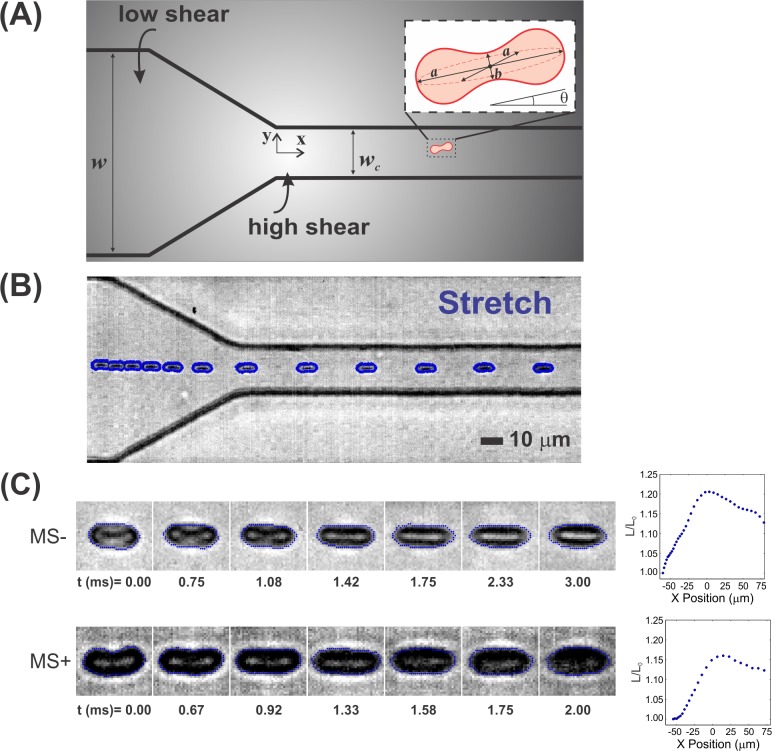
(A) Schematic of the microfluidic device. Dilute RBCs are pumped from a region of low shear (a wide channel, at left) to a region of high shear (the constriction, at right). Note that the origin is at the center of the entrance of the constriction as shown on the figure. (B) Representative superimposed series of time-lapse images extracted from high speed video each showing an individual RBC entering a constriction and stretching in response to the increased velocity. The original “raw” image of the RBC is shown in grayscale with the detected cell borders superimposed in blue. (C) High magnification time lapse images of a representative stretching RBC upon entering a constriction for Control (OMA-) and OMA+. Each image is cropped and centered on the RBC to illustrate its behavior. The box size is 10.2 μm x 10.2 μm. The corresponding plots at the right show major axis length, L, over initial major axis length, L0, as a function of the position in the channel.